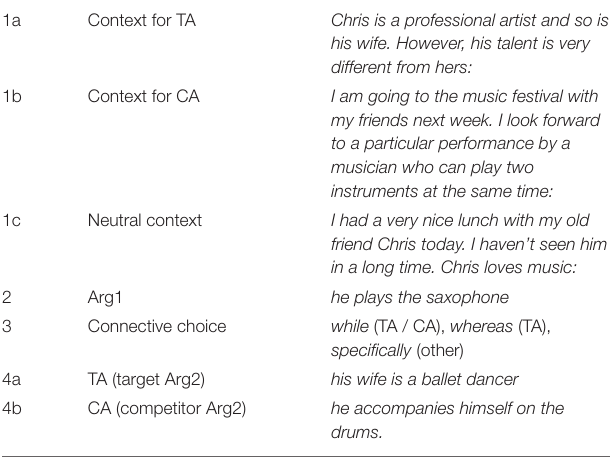
TABLE 1 | Material construction pattern illustrated with a concrete